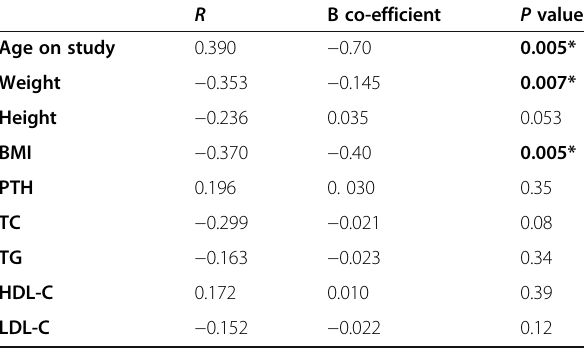
Table 2 Spearman ’ s correlation coefficient of25-OH VD with different anthropometric and laboratory variables B